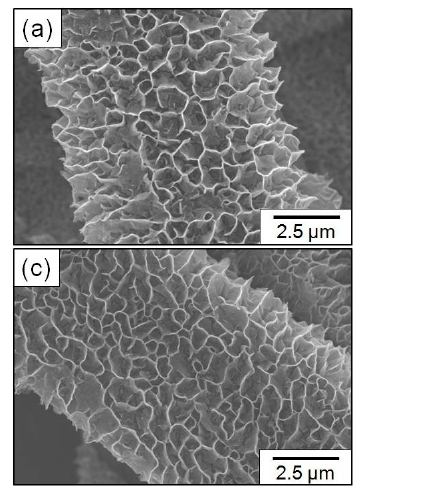
Figure 4. Top-view SEM images of ( a ) as-formed Pt-CNWs, ( b ) Pt-CNWs after the 3000-cycle test in PBS solution without H 2 O 2 , ( c ) Pt-CNWs after immersion in PBS solution with 240 µ M of H 2 O 2 for 42 hours, and ( d ) Pt-CNWs after immersion in PBS solution without H 2 O 2 .